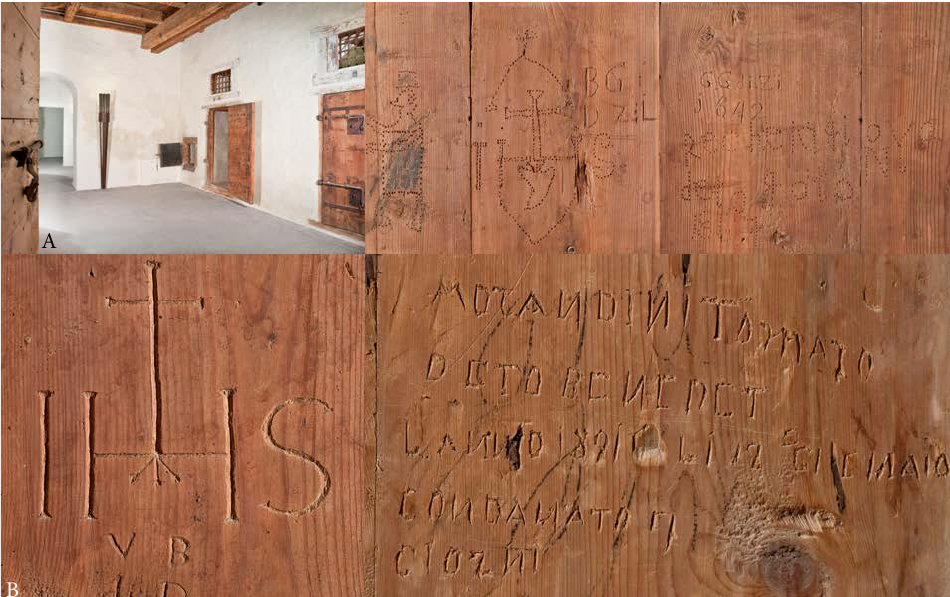
Figure 8 – Cavalese, the prisons of the Magnifica Comunità di Fiemme . A: ante-cell. B: writings on the wooden walls of the prisons. Courtesy of Museo degli Usi e Costumi della Gente